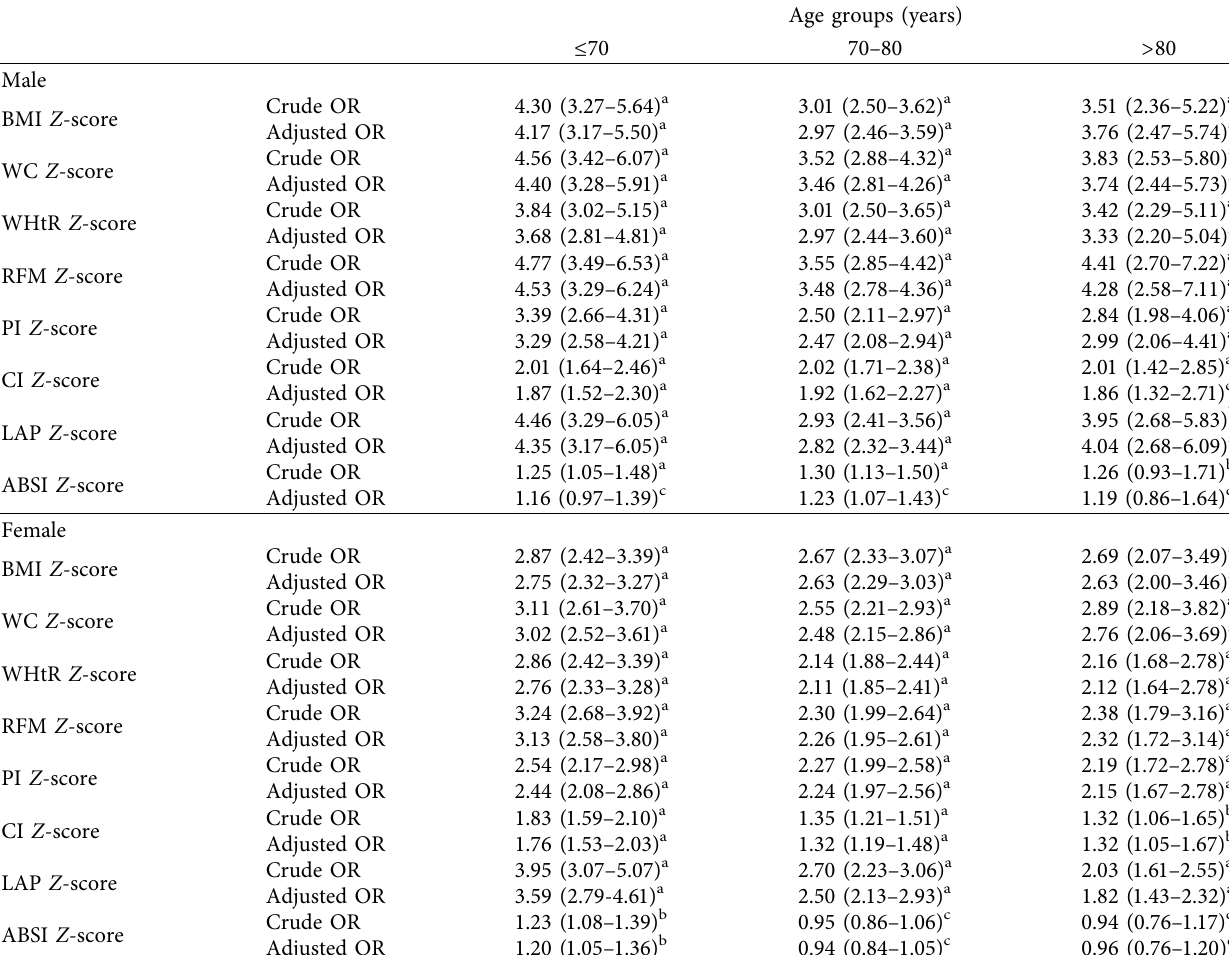
Table 5: Standardized odds ratios and 95% confidence interval of different anthropometric indexes for NAFLD under gender and age